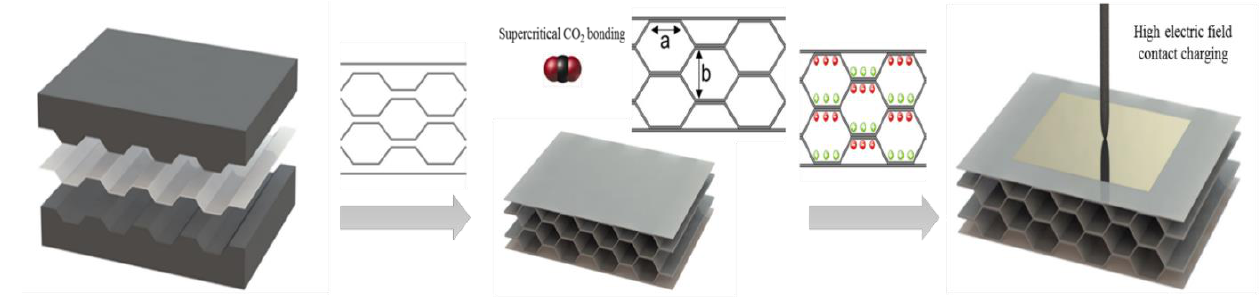
Figure 6. Schematic illustration of the fabrication procedure of the COC piezoelectric foam.